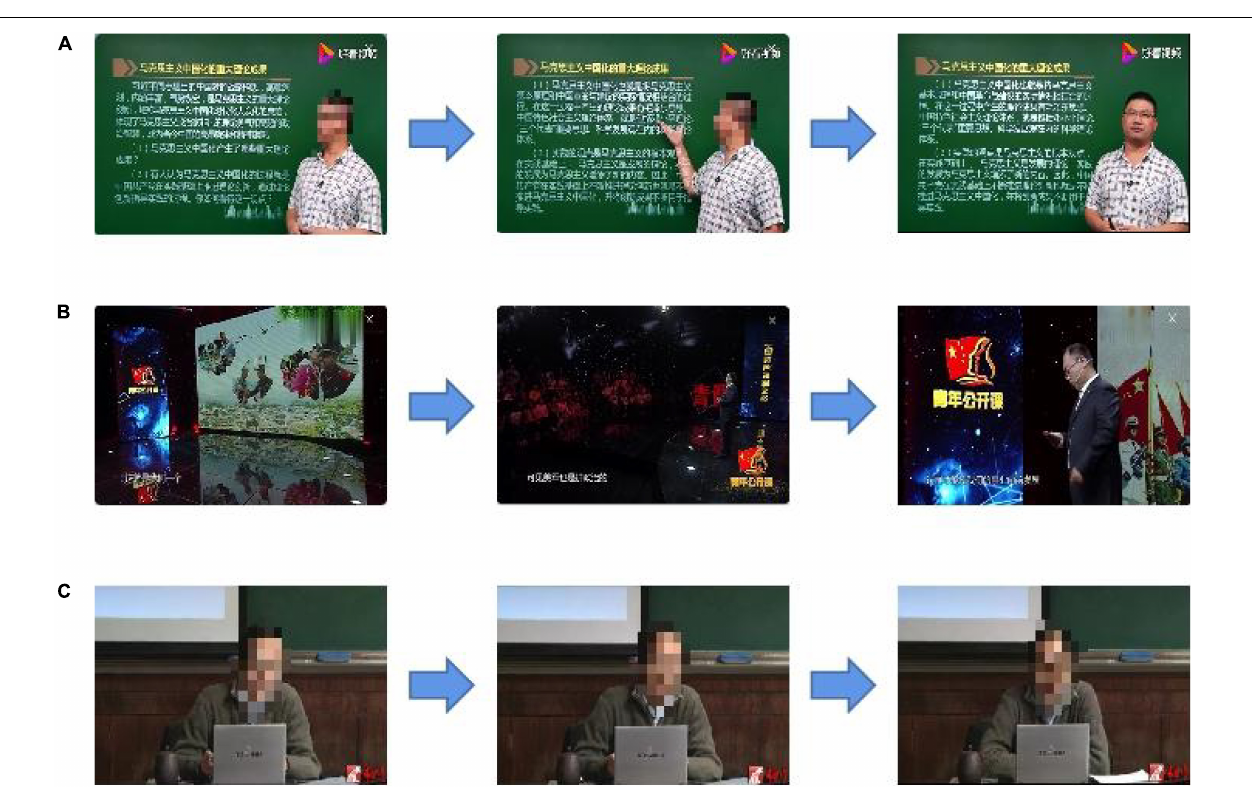
FIGURE 9 | Frame of videos ( A , course 1; B , course 2; and C , course